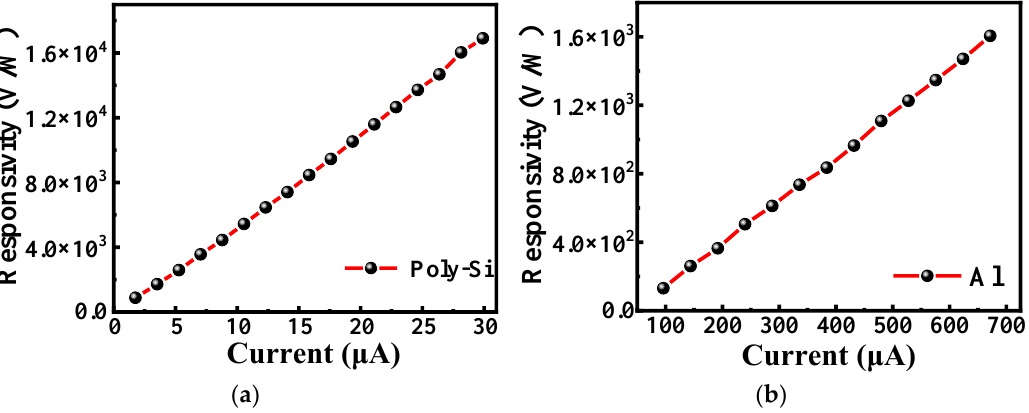
Figure 6. The responsivity as a function of bias current of ( a ) salicide polysilicon microbolometer and ( b ) metal Al microbolometer.